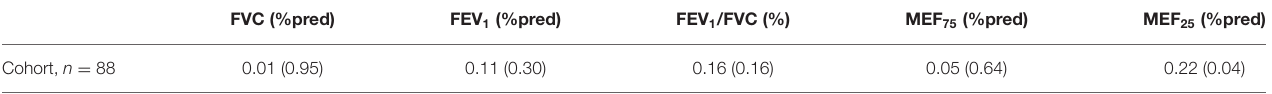
TABLE 3 | Relationship of relative total nasal airflow (RTNAF, %pred) with relative spirometry parameters in children with